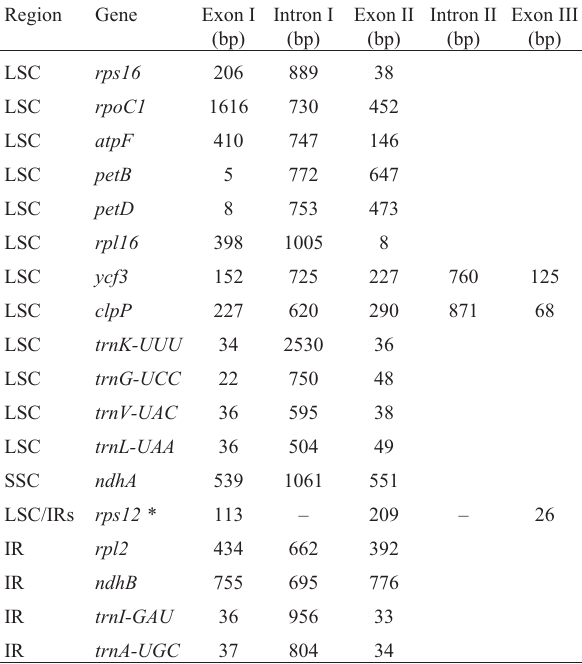
Table 3 - Genes with introns in Campomanesia xanthocarpa chloroplast genome and length of exons and